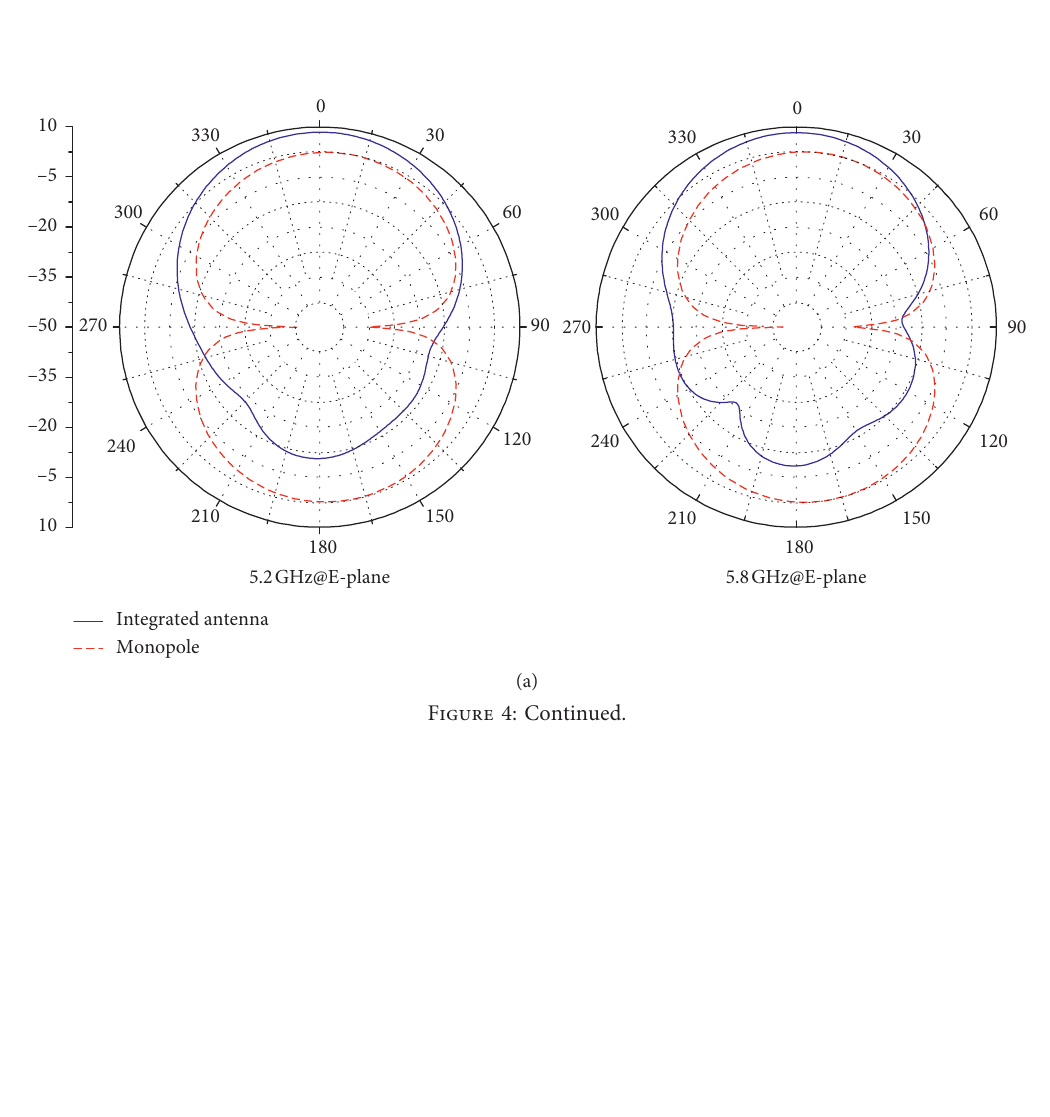
Figure 3: Simulated and measured (a) S11 and (b) VSWR.